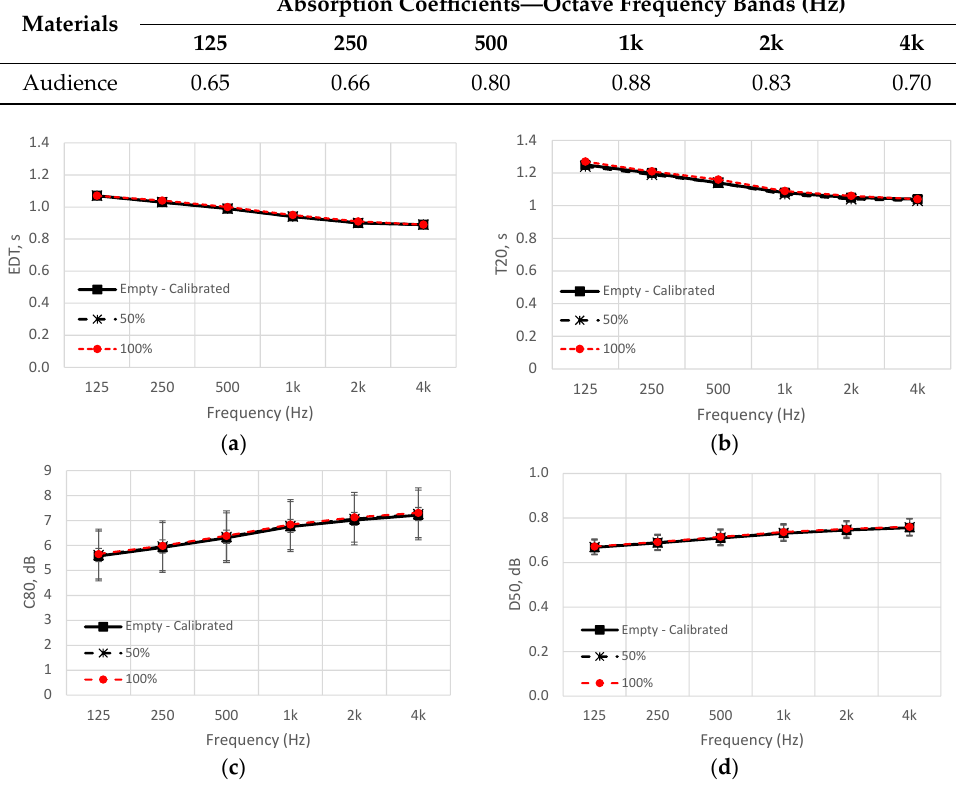
Figure 11. Simulated results of the acoustic parameters: EDT ( a ), T 20 ( b ) C 80 ( c ) and D 50 ( d ).